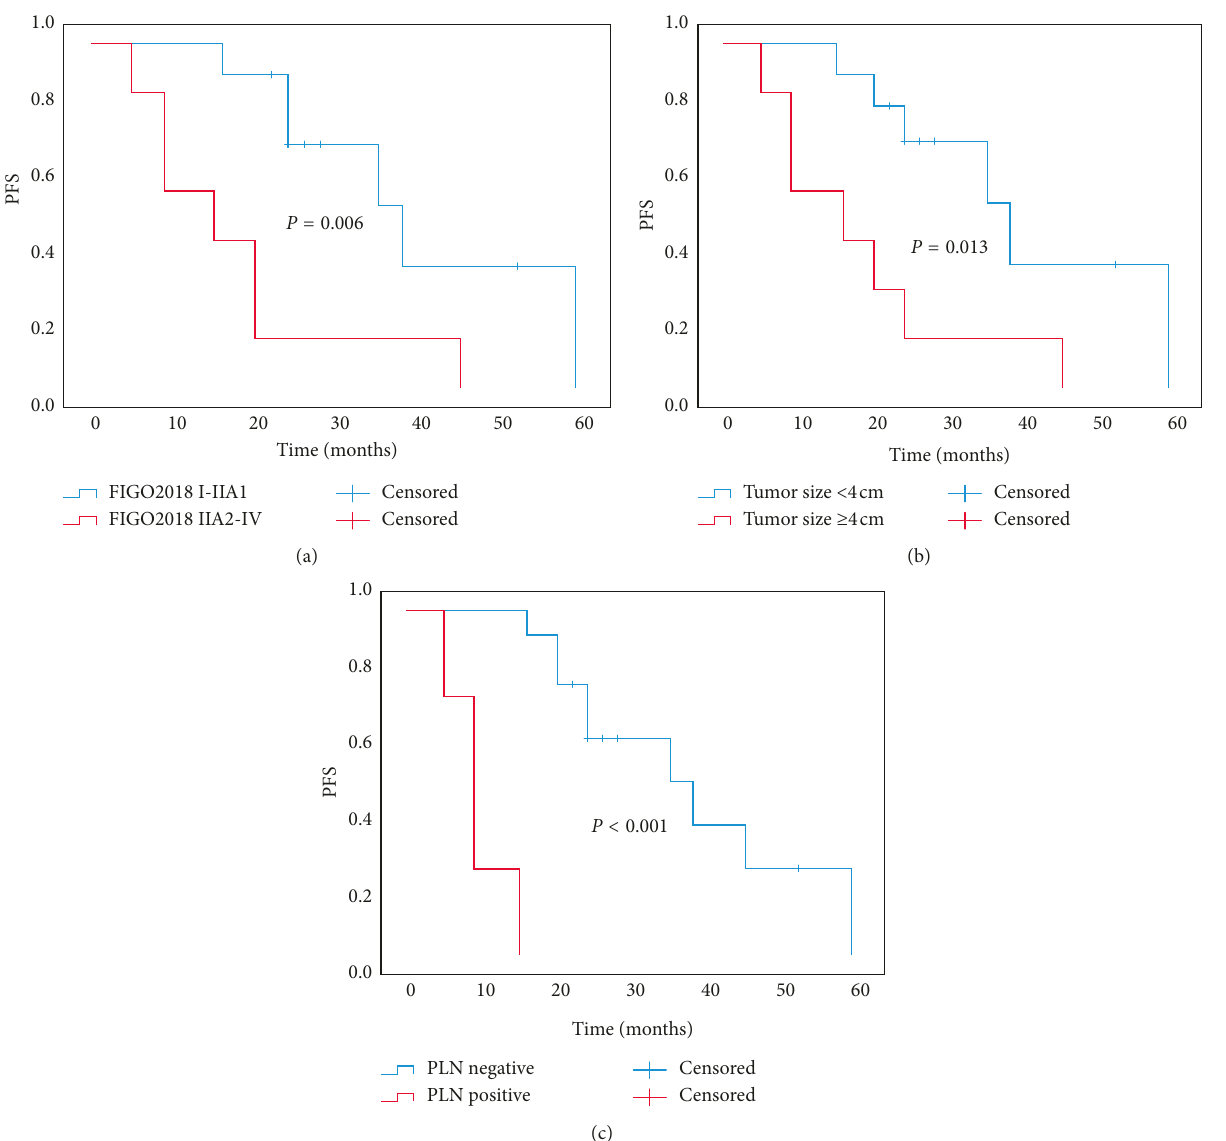
Figure 2: Kaplan–Meier curve of PFS. (a) The PFS for stages I to IIA1 and stages IIA2 to IV ( P and 4cm ( P 0 . 013). (c) The PFS for PLN metastasis positive and negative patients ( P (cid:31) ≥